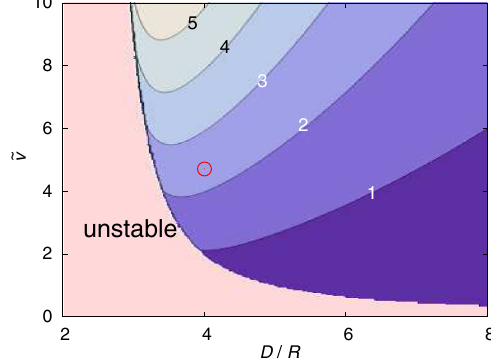
FIG. 8. Stability of a trapped vortex dipole with respect to the distance D between the potentials and the normalized velocity ~ v ¼ 2 (cid:1)Rv=(cid:12) . When (cid:14) in Eq. (15) is real, the system is dynami- cally unstable. The contour plot shows 2 (cid:1)R 2 j (cid:14) j =(cid:12) where (cid:14) is purely imaginary. The circle corresponds to the case in Fig. 7.